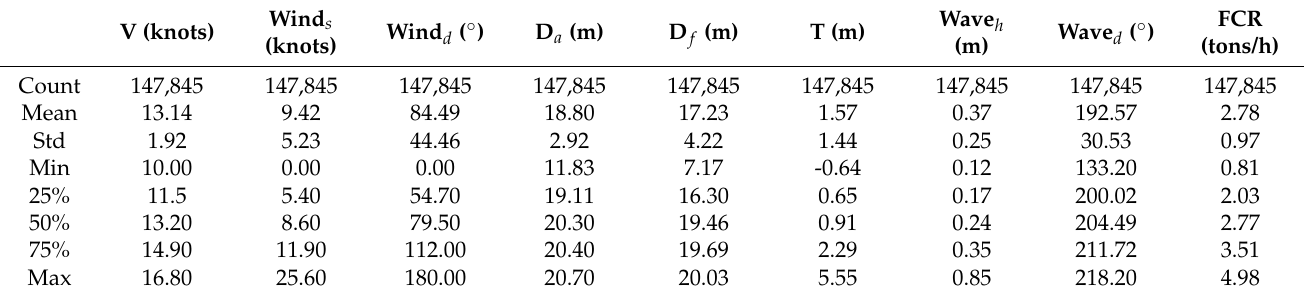
Table 1. Statistics of the modeling input features.